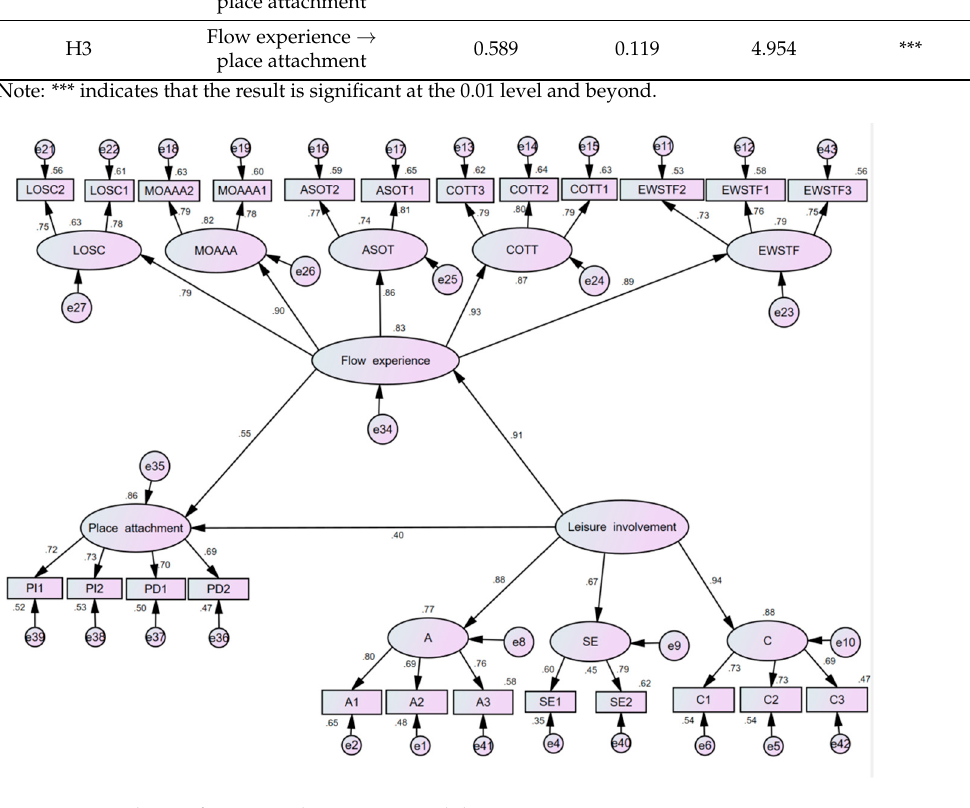
Figure 3. Analysis of structural equation modeling.